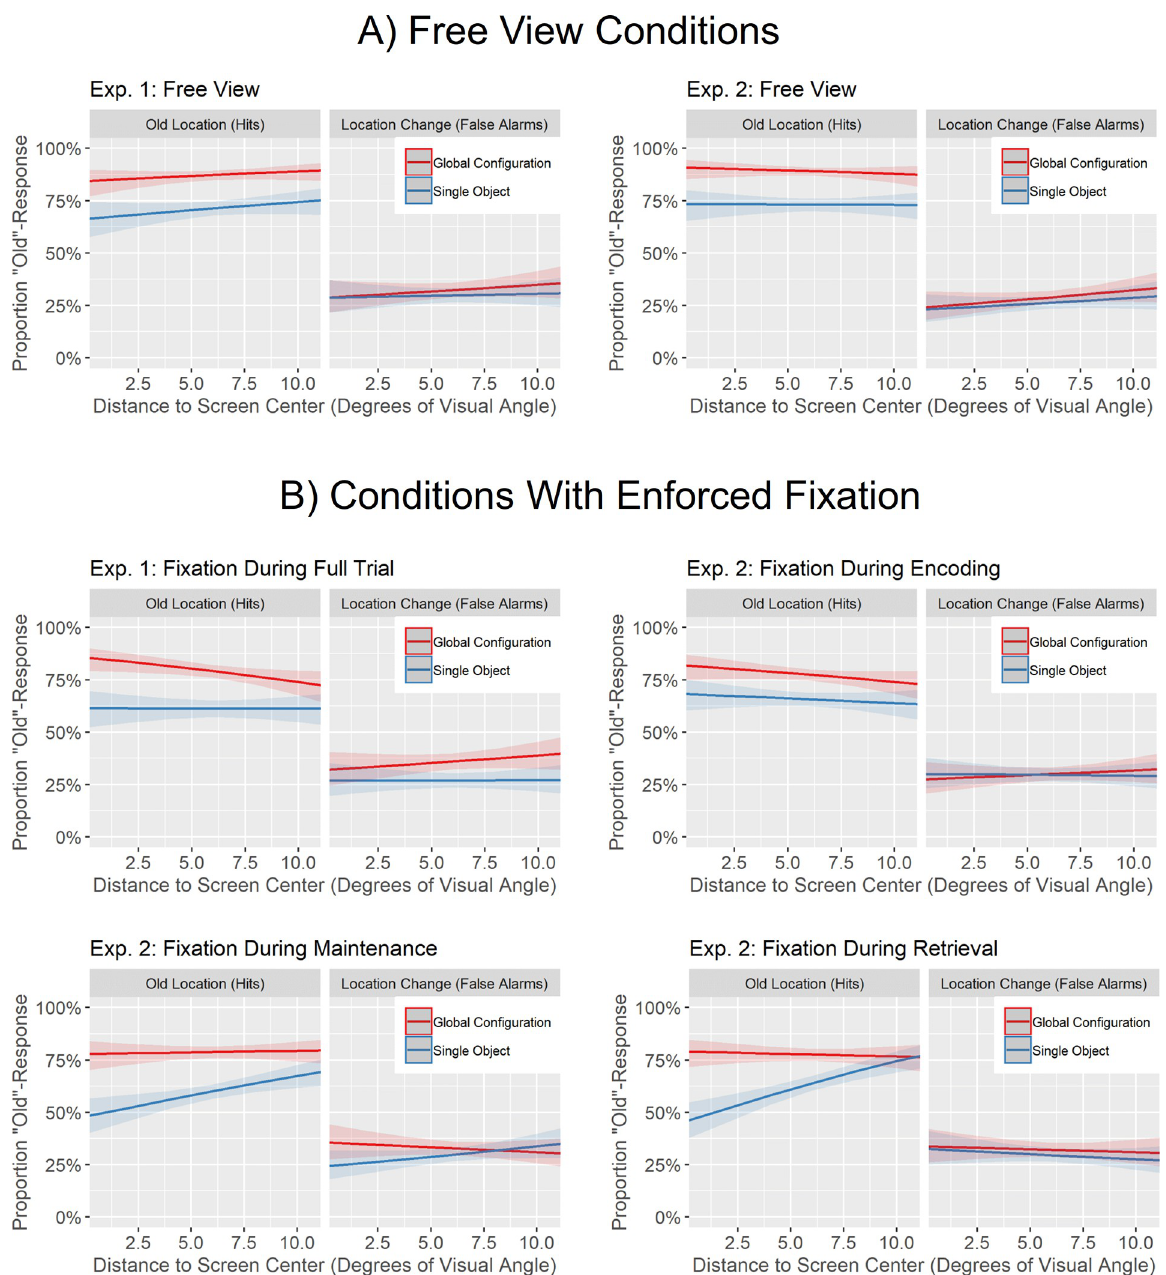
Fig 5. Predicted probabilities derived from the generalized linear mixed effect models to the experimental conditions of Experiments 1 and 2 to investigate the influence of the distance of the probed object to the center of the screen (during encoding) on hit rates and false alarm